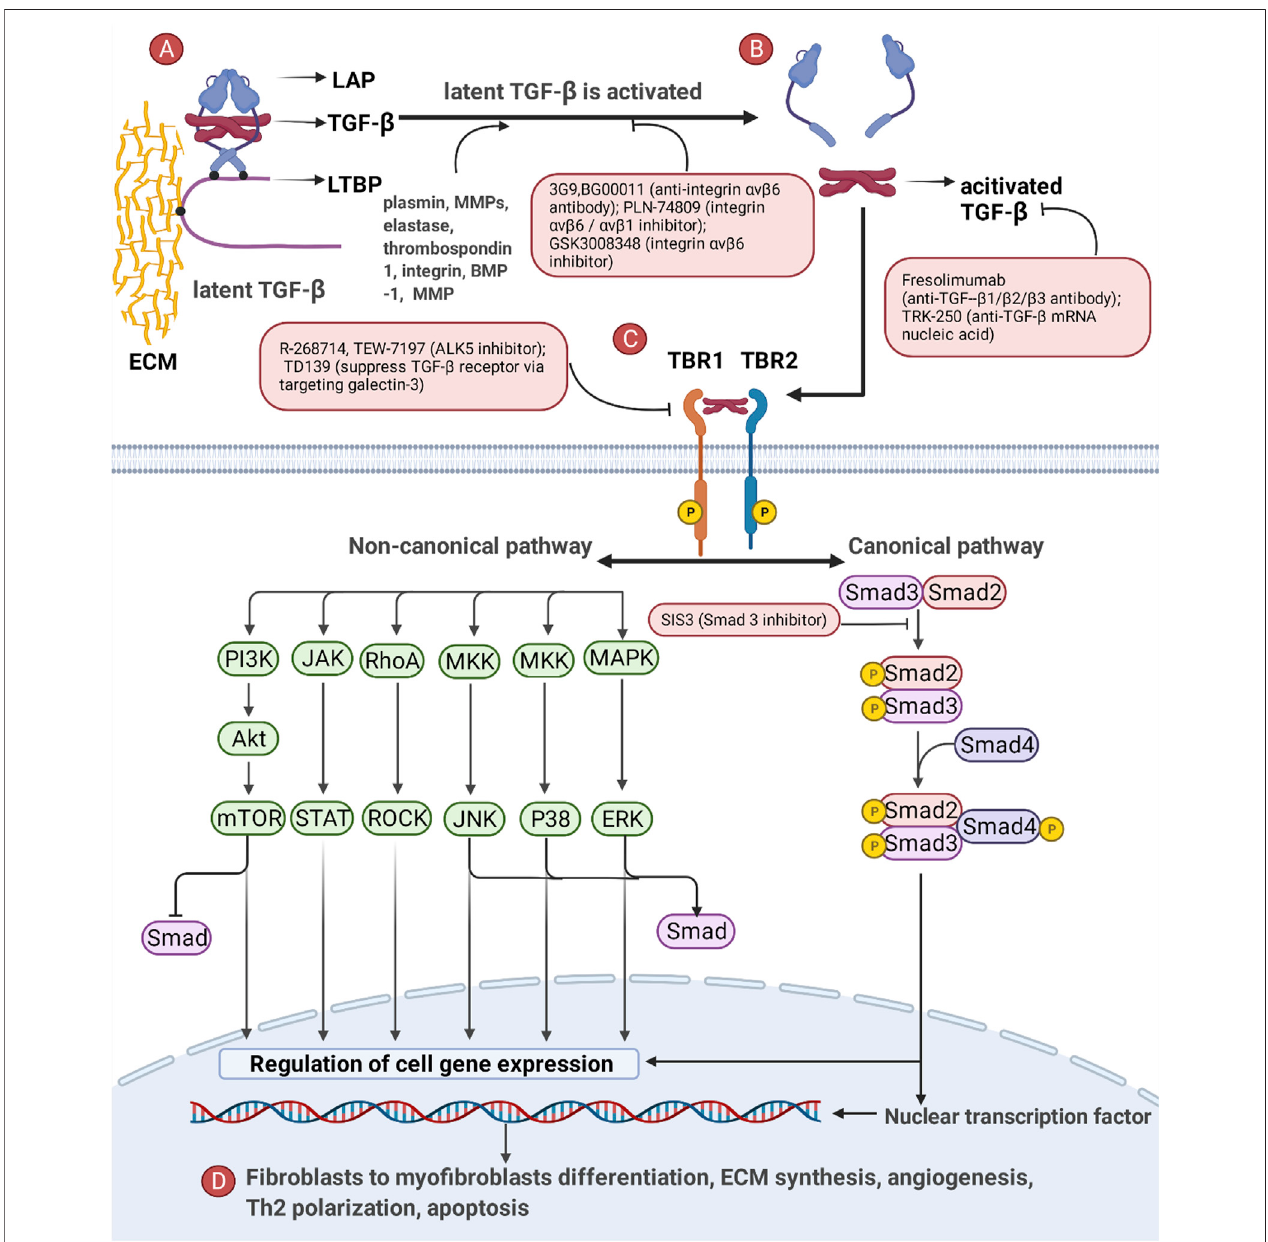
FIGURE 2 | The critical role of the TGF- β pathway and drugs targeting the TGF- β pathway in IPF. (A) Latent TGF- β (TGF- β trapped in LAP) binds to ECM through LTBP. (B) TGF- β is detached from LAP and activated only in the presence of speci fi c stimuli. (C) Activated TGF- β activates the downstream Smad-dependent pathway (canonical pathway) and Smad-independent pathway (non-canonical pathway) by combining with TBR. (D) The TGF- β pathway ultimately causes phenotypic reprogramming of AECs, fi broblasts and immune cells and in fl uences fi broblast-to-myo fi broblast differentiation, ECM synthesis, angiogenesis, Th2 polarization, and